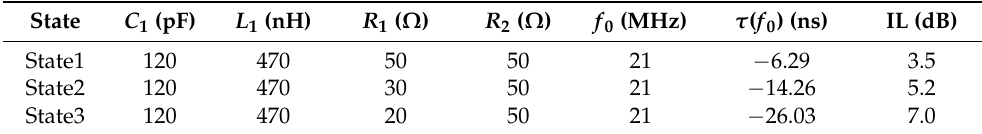
Figure 3. Band-pass negative group delay with different R 1 . Table 2. Data of band-pass negative group delay circuit with different R 1 .